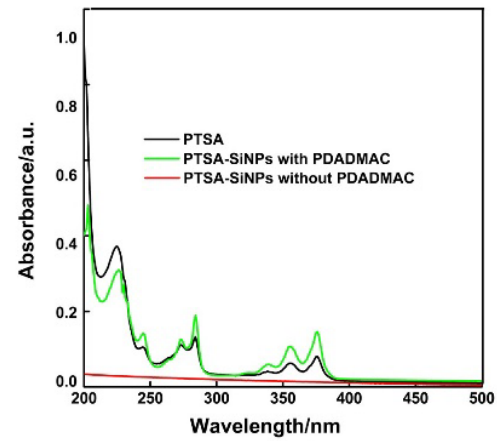
Figure 3. UV absorption spectra of the original PTSA and PTSA-SiNPs prepared with and without PDADMAC as the intermediate in H 2 O (concentration 10 −6 M). The concentration refers to the final concentration of PTSA in the solution. The original PTSA solution was prepared by direct calculation and weighing. PTSA-SiNP suspension solution is prepared based on the absorption spectra of the PTSA at Lambert–Beer law.